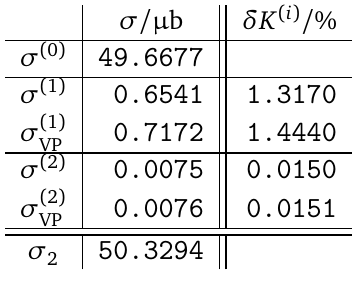
Table 4: Results for the integrated cross section for the MUSE setting at LO, NLO, and